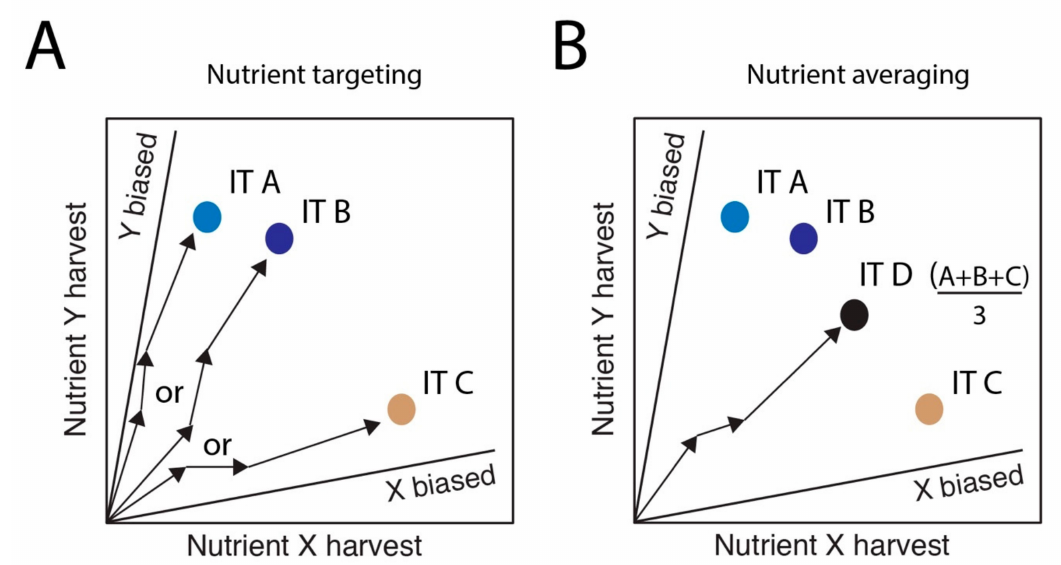
Figure 2. Nutritional geometry predictions of nutrient targeting and nutrient averaging in a diet-choice experimental set-up. ( A ) A nutrient-targeting hypothesis, assumes that a foraging insect can maintain information in separate neurophysiological channels about nutritional needs of itself, its nestmates and its mutualist(s). Here, an insect will forage across available foods in several distinct ways, targeting a diet mixture that specifically matches its own physiological needs (IT A), the needs of its nestmates (IT B), or targeting the specific nutritional deficiencies remaining after receiving nutrients from mutualists (IT C). The arrows represent the switches in foraging between X-biased and Y-biased diets used to reach the final IT. ( B ) A nutrient-averaging hypothesis assumes that the insect optimally integrates the di ff erent information from itself and partners to yield an averaged summary of communal needs. Here, an insect will target an intermediate diet mixture (IT D) that may save time and energy spent in foraging, but is also likely to suboptimally match the needs of each